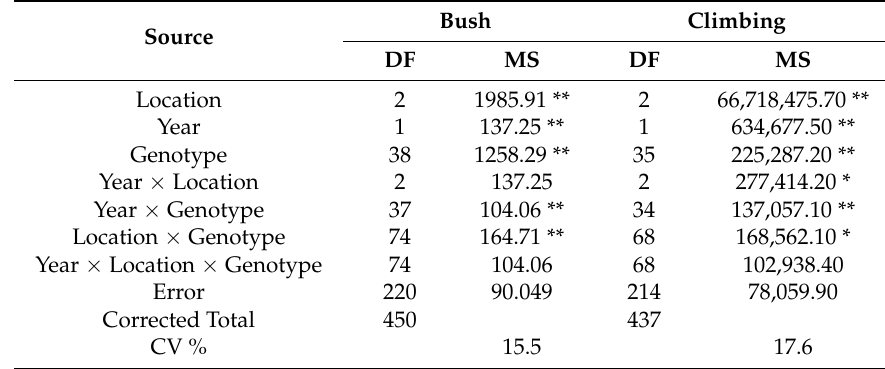
Table 3. Analysis of variance of the relative area under disease progress curve (RAUDPC) of bean genotypes tested in